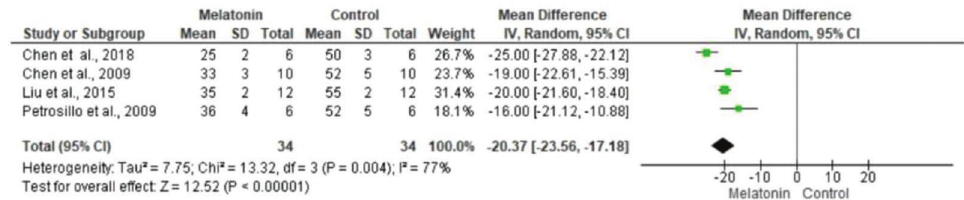
Figure 3a - Metanalysis of infarct size measurement by echocardiography (% left ventricular).